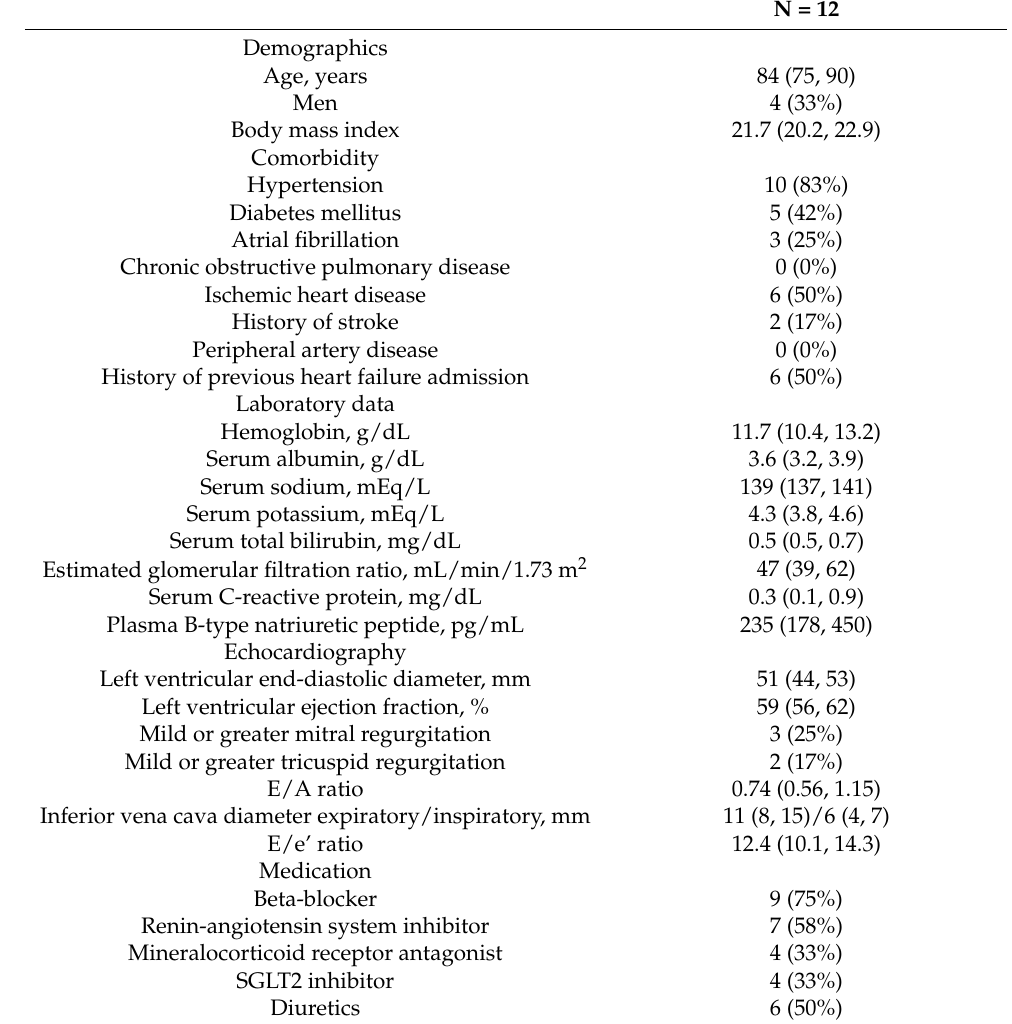
Table 1. Baseline